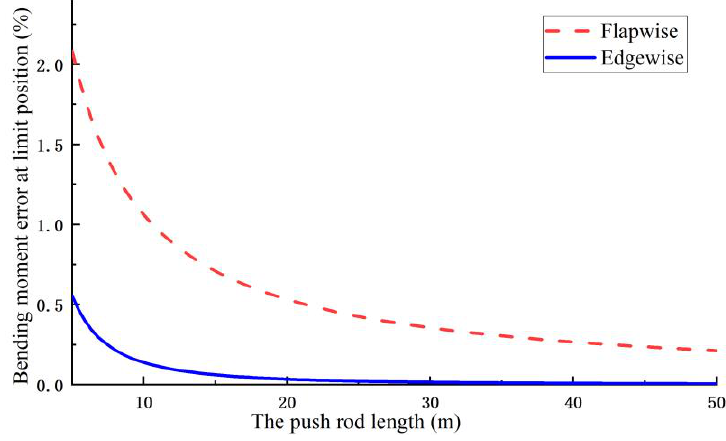
Figure 13. Change trend diagram of bending moment error with the increase in rod length.